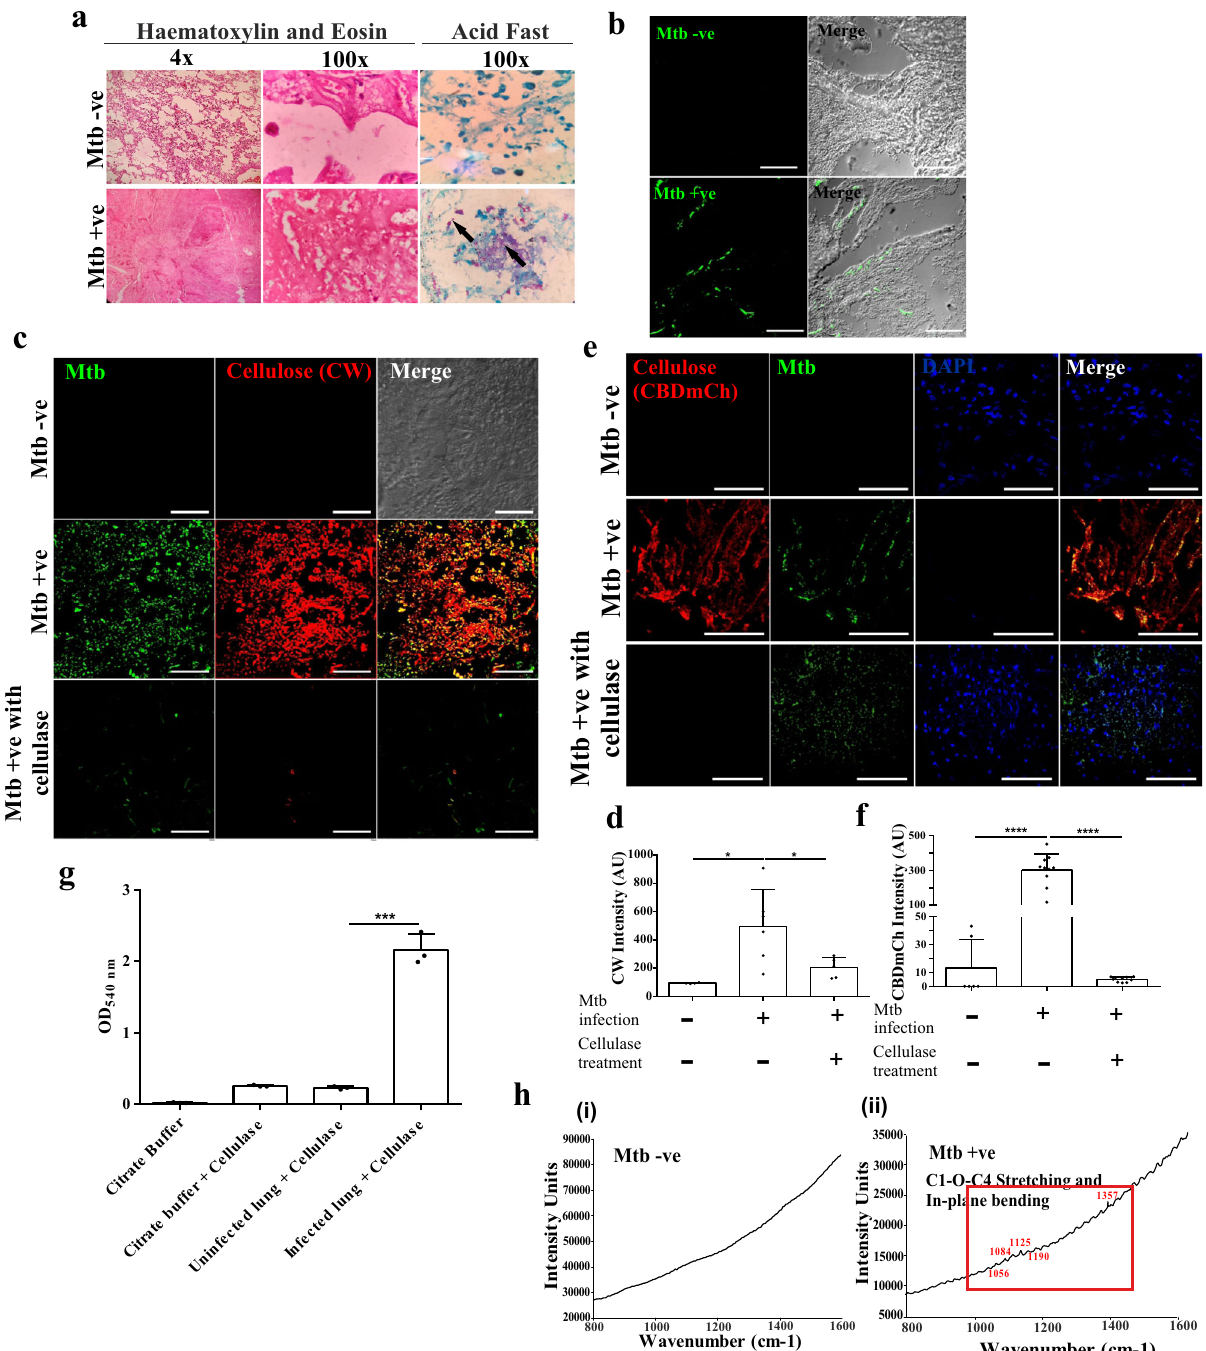
Fig. 7 Mtb forms bio fi lms in the human lungs. a H & E staining of human lung tissue sections. The clusters of acid-fast bacilli are denoted by arrows. b FISH with Mtb speci fi c 16 S primers was utilized for identifying lung tissues infected with Mtb. c , d Cellulose was visualized using CW staining in Mtb positive and Mtb negative human lung tissue sections. Mtb bacilli were visualized using Auramine B – Rhodamine O staining. Mtb positive tissue sections were also stained with CW after Cellulysin Cellulase treatment. e , f CBD-mCh staining and visualization of Mtb (Auramine B – Rhodamine O) in Mtb positive and Mtb negative lung tissue sections. g DNS assay on Mtb positive and Mtb negative human lung tissue blocks after treatment with Cellulysin Cellulase. h Raman microscopy of ( i ) Mtb positive and ( ii ) Mtb negative human lung sections. The column bar graphs presented in fi gures d , f and g have been plotted in GraphPad Prism 6 and represented as mean (±s.e.m). Statistical signi fi cance was determined using Student ’ s t -test (two tailed). * P < 0.05, ** P < 0.001, *** P < 0.0001. For d * P = 0.0169 (column A vs column B) and * P = 0.0401 (column B vs column C), for f **** P < 0.0001 and for g *** P = 0.0001 All data are representative of three independent biological experiments performed in triplicates. Scale bars correspond to 50 μ m. All source data are provided as a Source Data fi